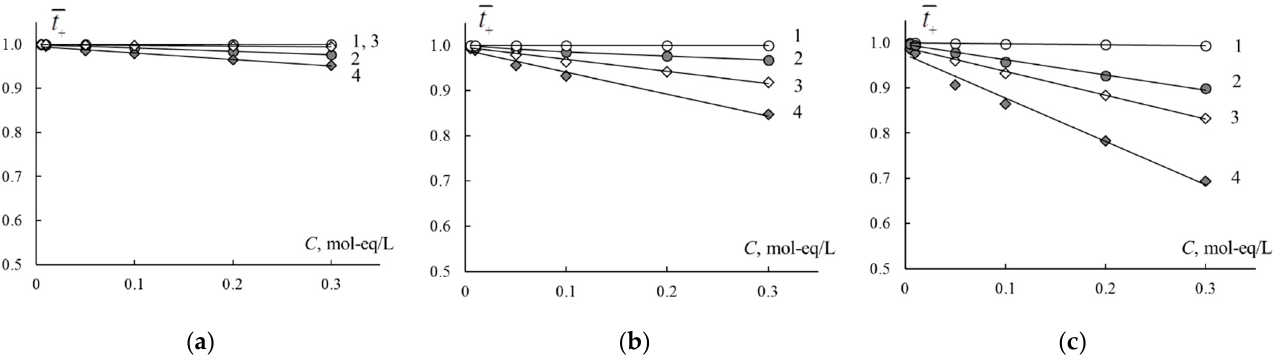
Figure 5. Transport numbers of counter-ions in the MF-4SK (1), MF-4SK/PANI (2), MK-40 (3) and MK-40/PANI (4) membranes in HCl ( a ), NaCl ( b ), CaCl 2 ( c ) solutions.